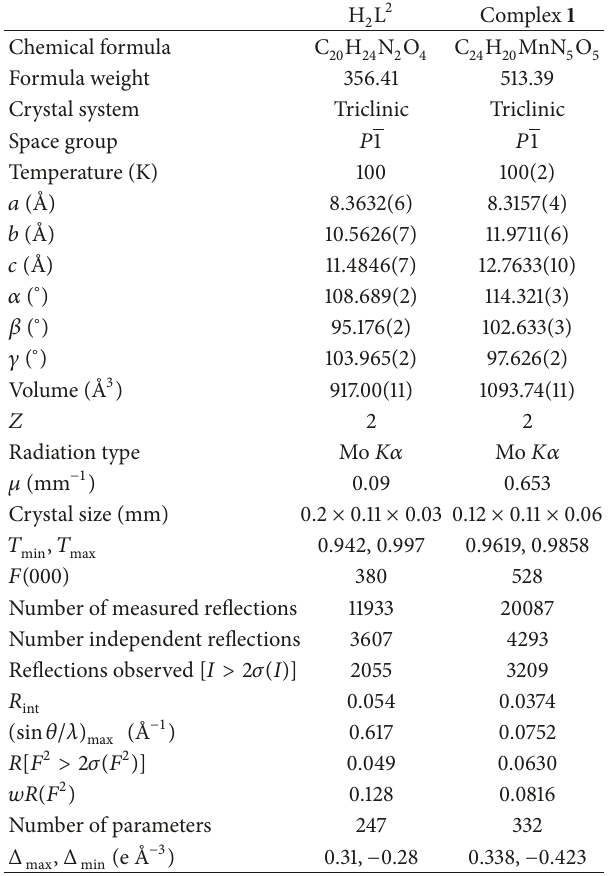
Table 1: Crystal data and structure refinement for H 2 L 2 and